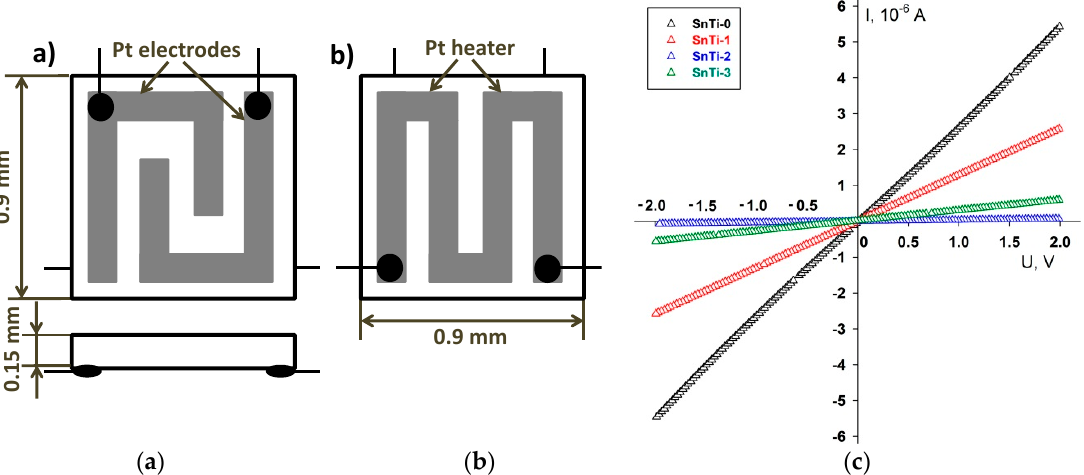
Figure 1. Micro-hotplate scheme: ( a ) front side; ( b ) back side; ( c ) Current–voltage (I-V) characteristics of the sensors.